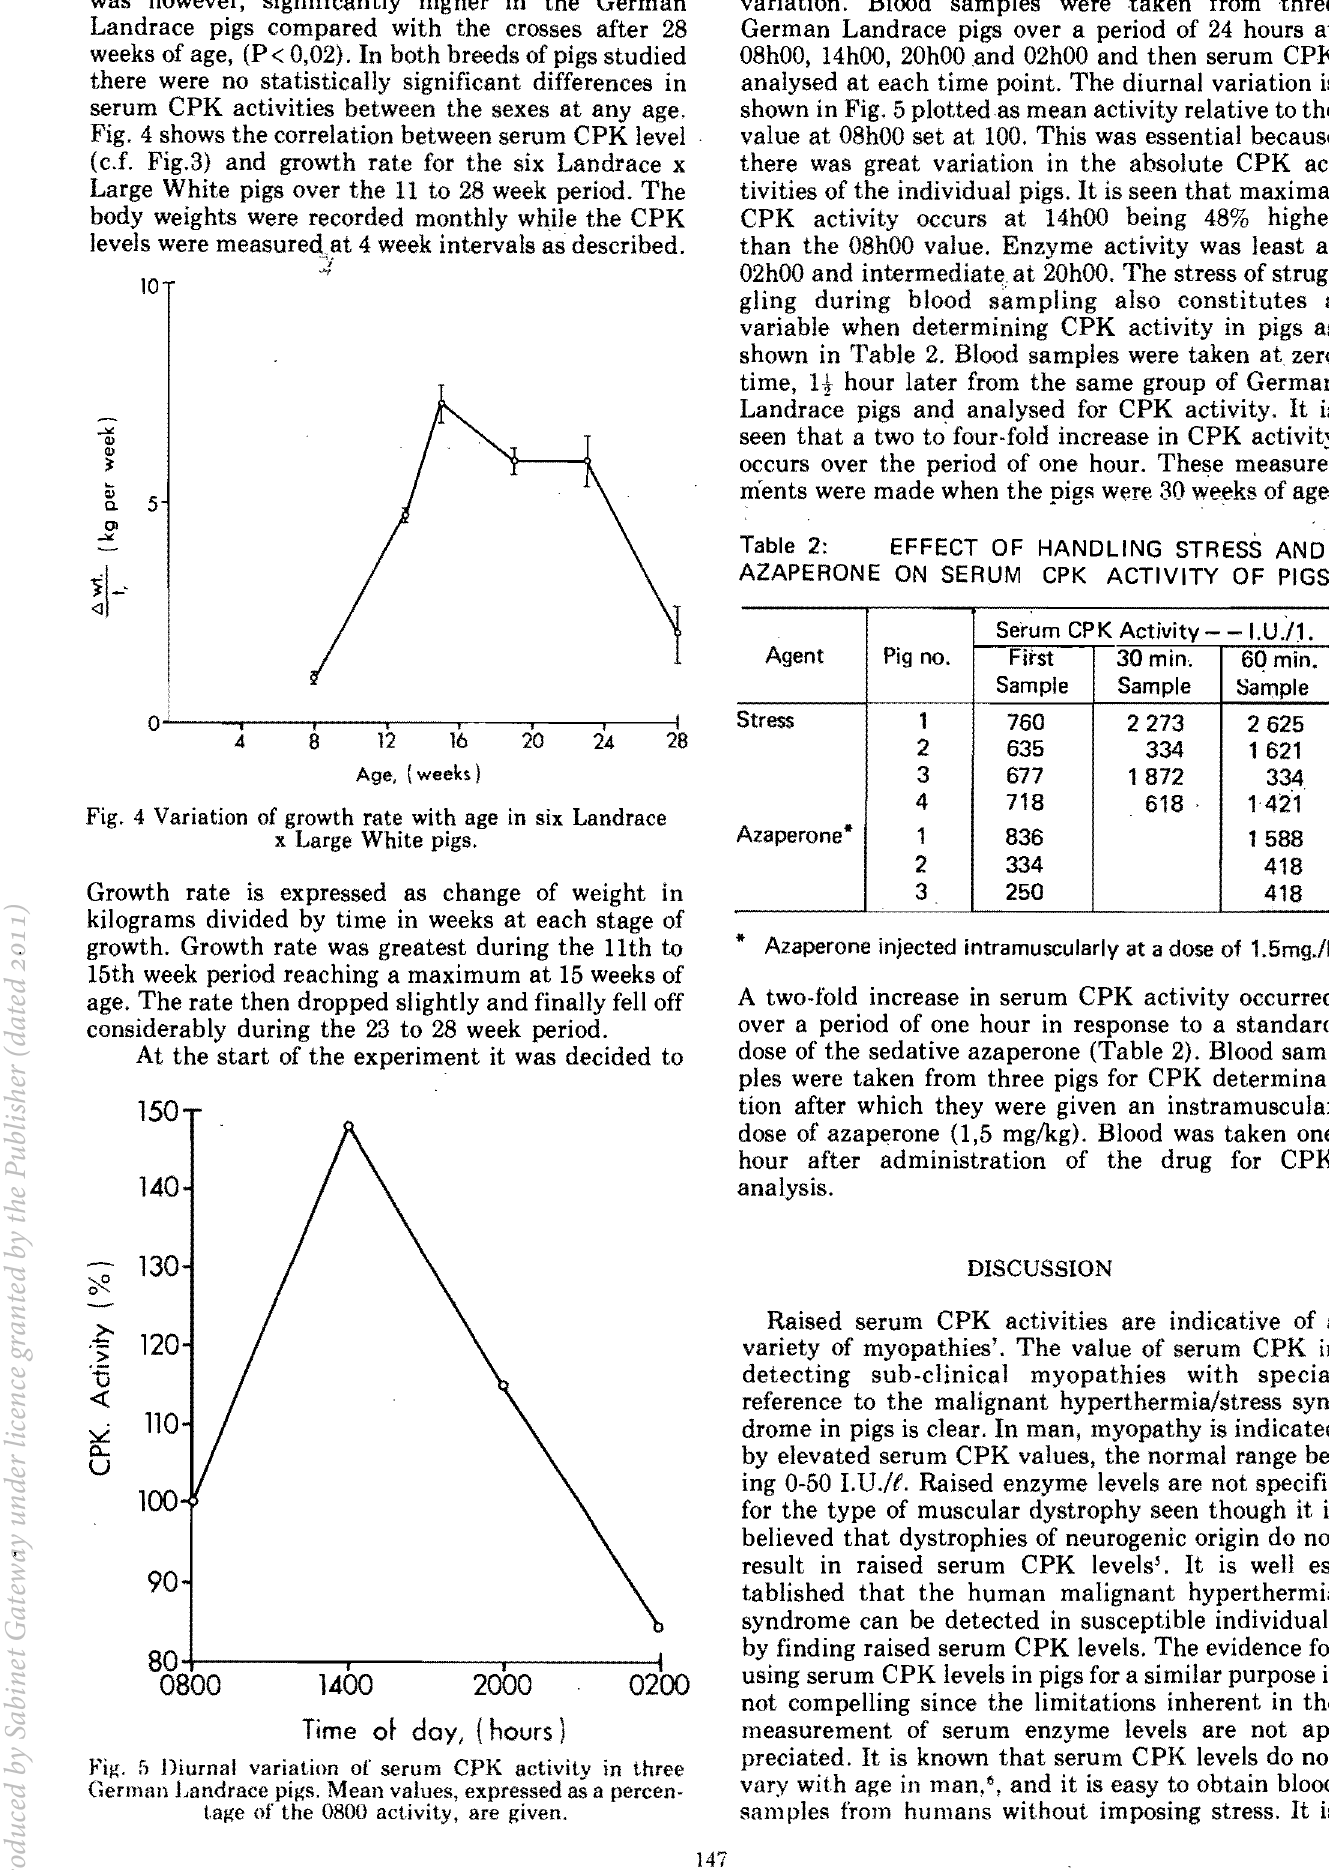
Fig. [) Diurnal variation of serum CPK activity in three German Landrace pigs. Mean values, expressed as a percen tage of the 0800 activity, are given.